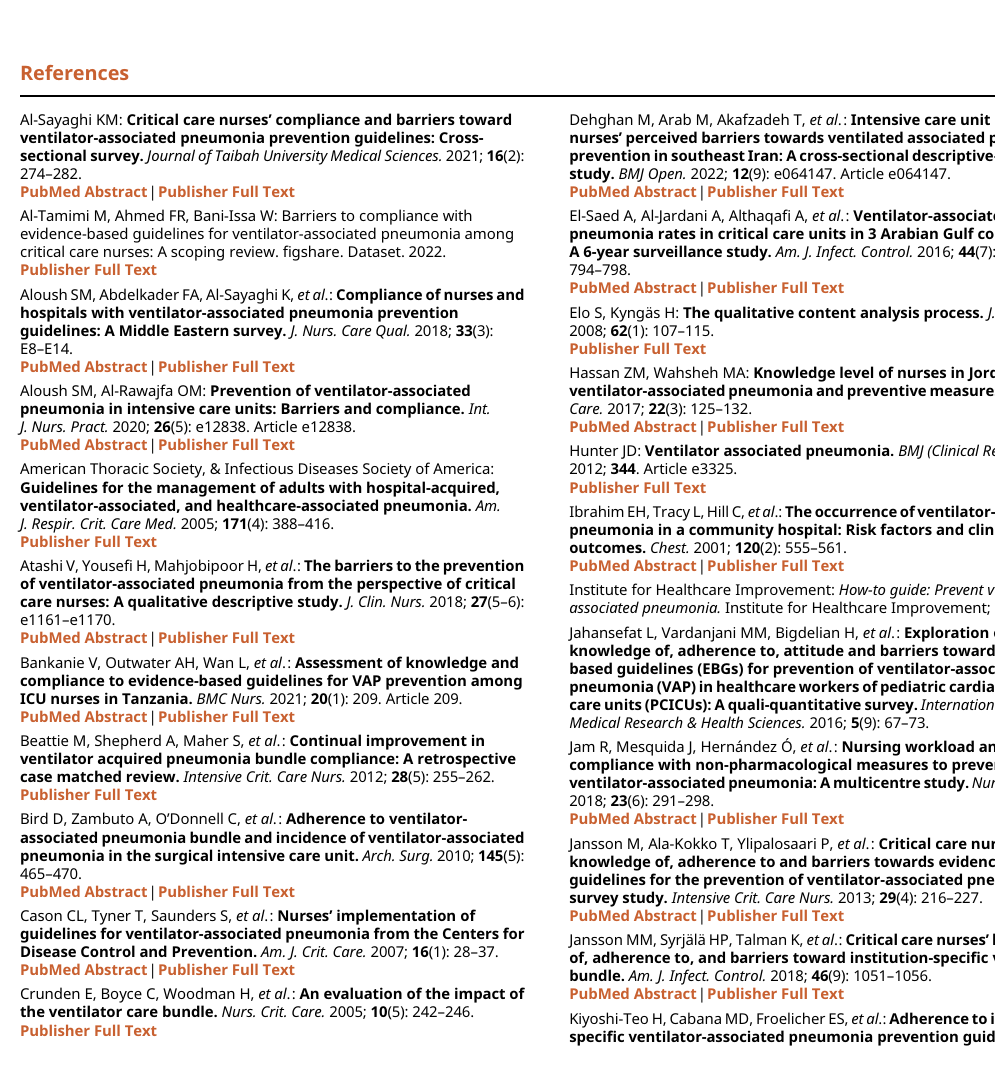
Figshare: PRISMA-Scr checklist for ‘ Barriers to compliance with evidence-based guidelines for ventilator-associated pneumonia among critical care nurses: A scoping review ’ , https://doi.org/10.6084/m9.figshare.21493122.v1 (Al-Tamimi et al ., 2022). Data are available under the terms of the Creative Commons Zero “ No rights reserved ” data waiver (CC0 1.0 Public domain